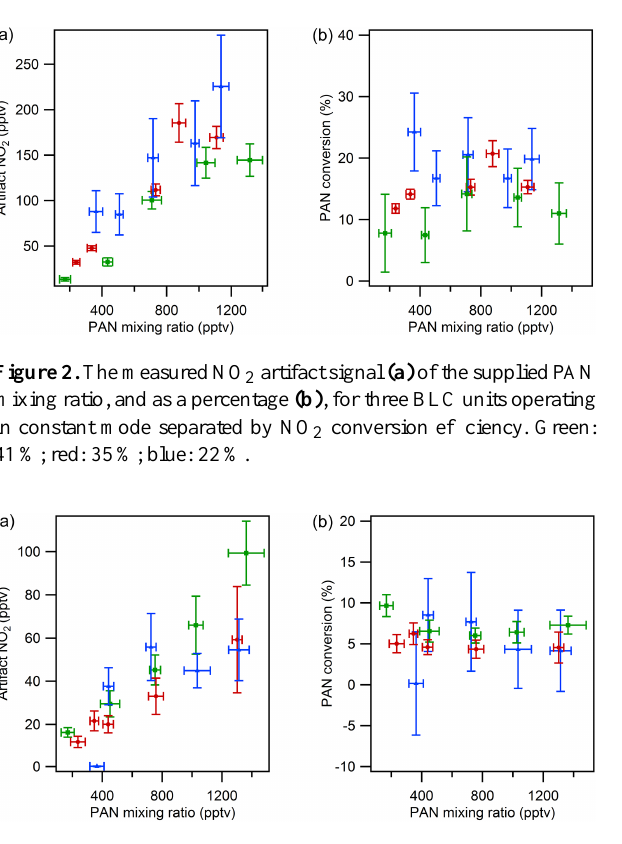
Figure 3. The measured NO 2 artifact signal as a function of the supplied PAN mixing ratio (a) , and as a percentage (b) , for three BLC units operating in switching mode separated by NO 2 conver- sion efficiency. Green: 41%; red: 35%; blue: